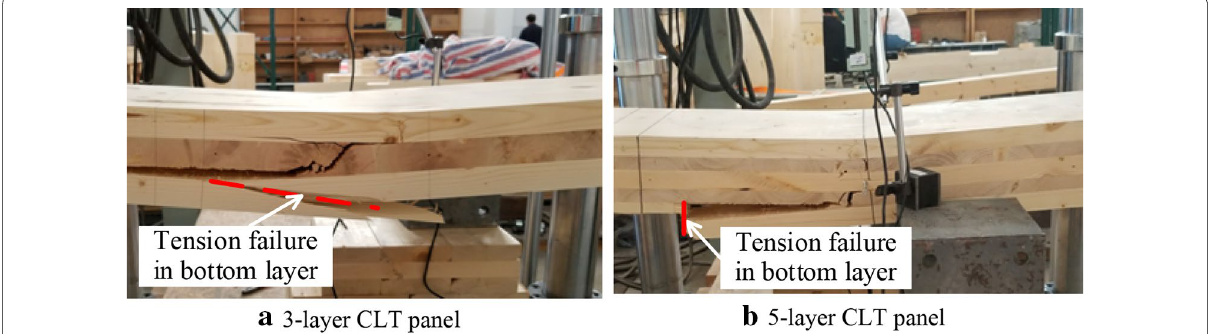
Fig. 8 Failure modes of the CLT bending panels